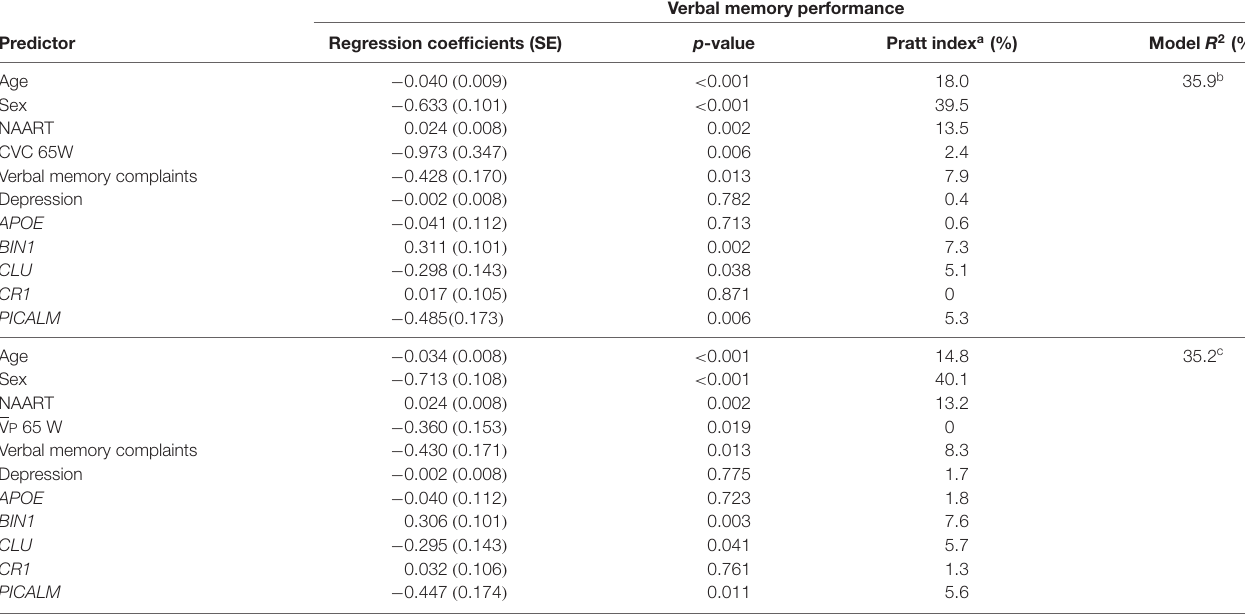
TABLE 3 | Results from multiple regression analysis and relative contribution of predictors of verbal memory performance in BIM Study participants using verbal memory complaints.